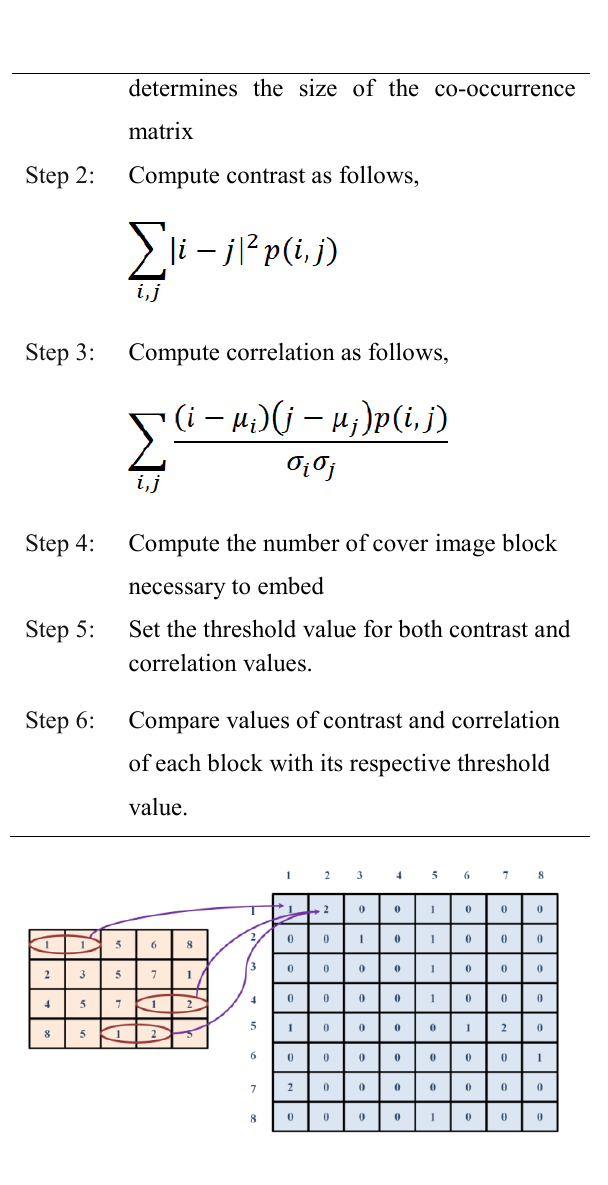
Fig. 2. Co-occurrence matrix